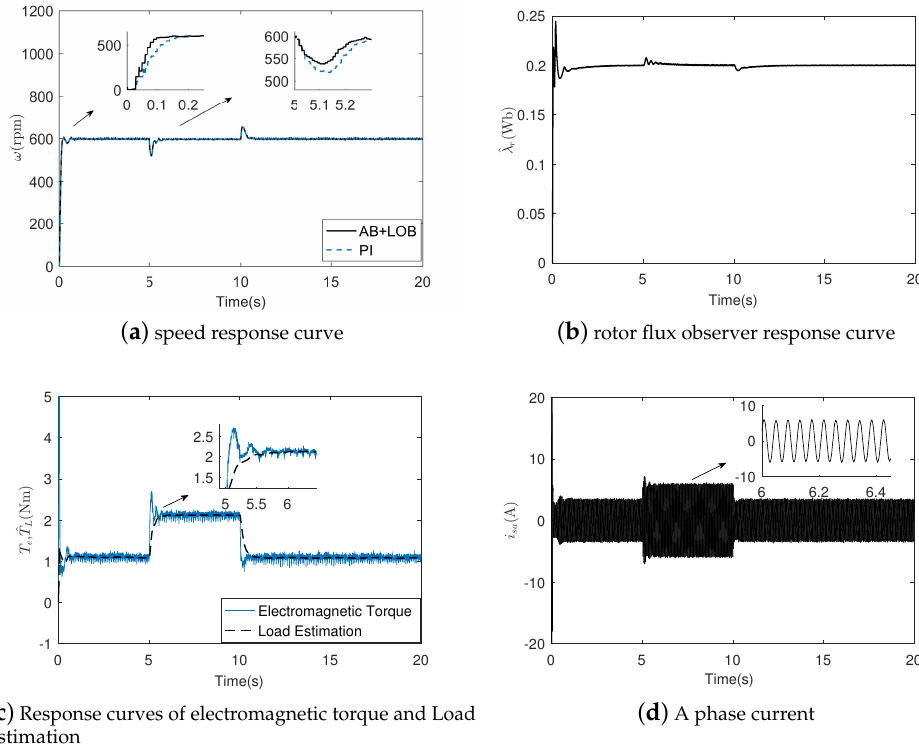
Figure 7. Response curves at 600